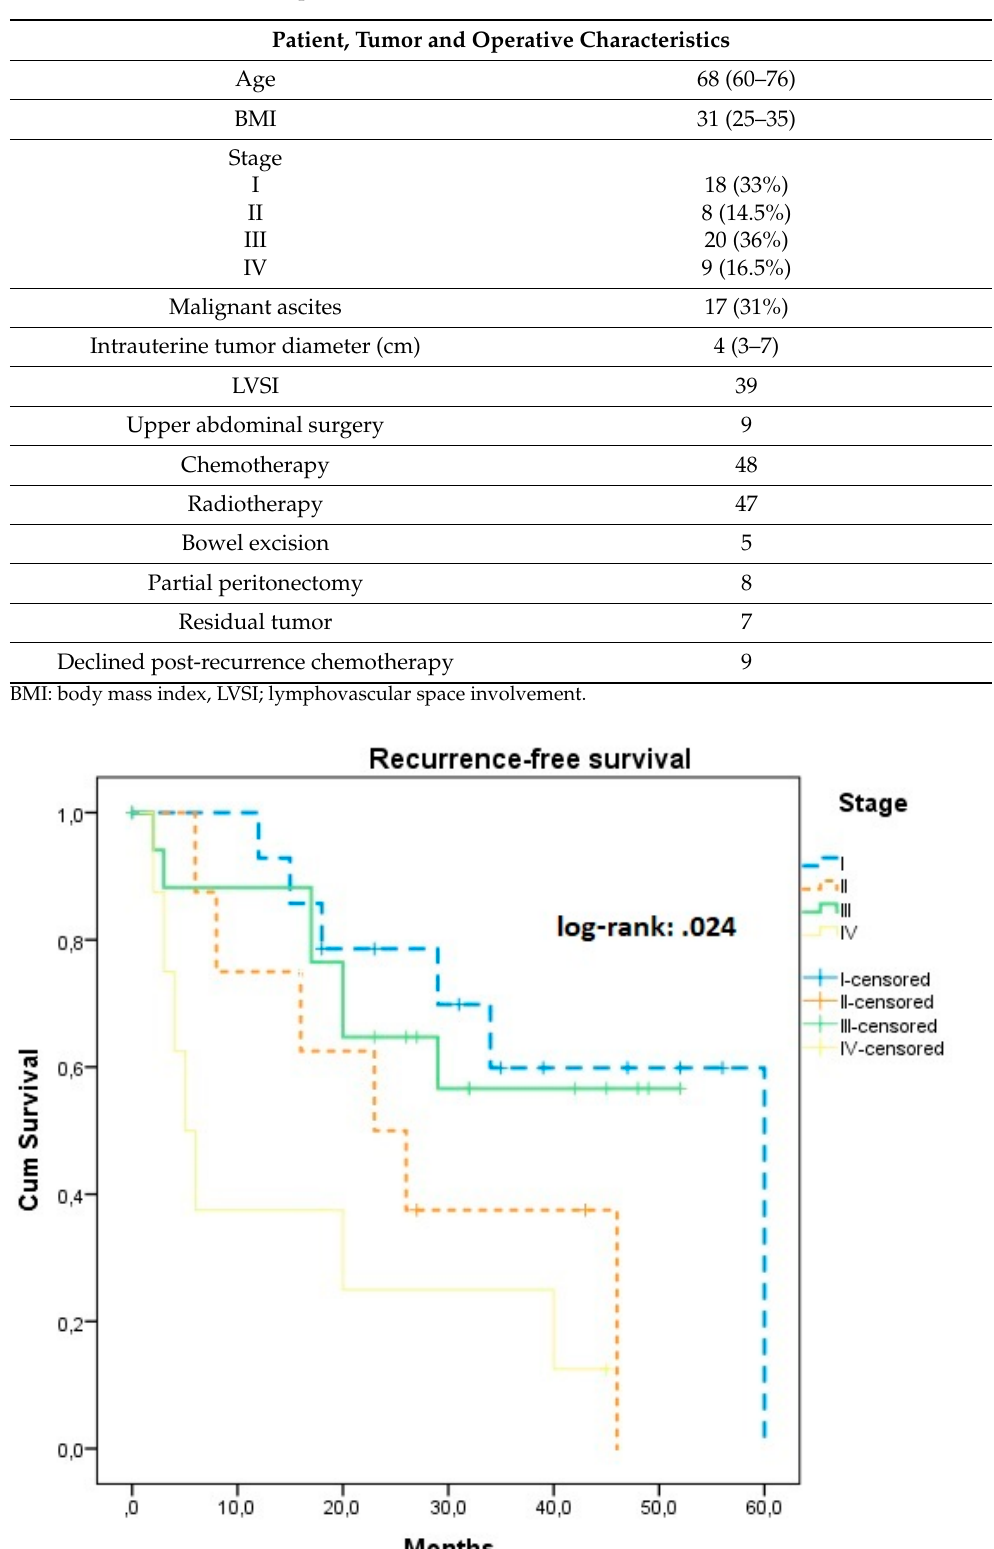
Table 1. Patient, tumor and operative characteristics.